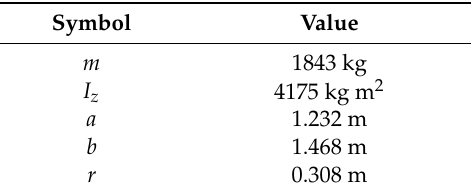
Table 4. Vehicle model